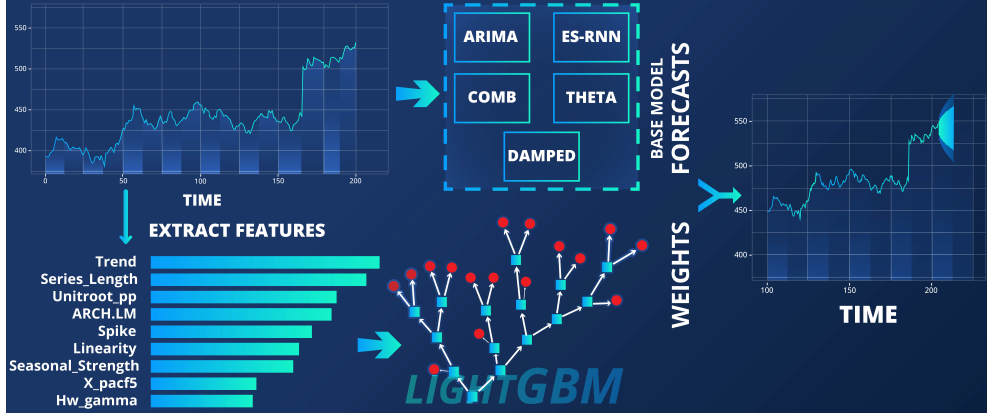
Figure 2. The FFORMA forecasting pipeline. Algorithm 1: FFORMA’s forecast combination